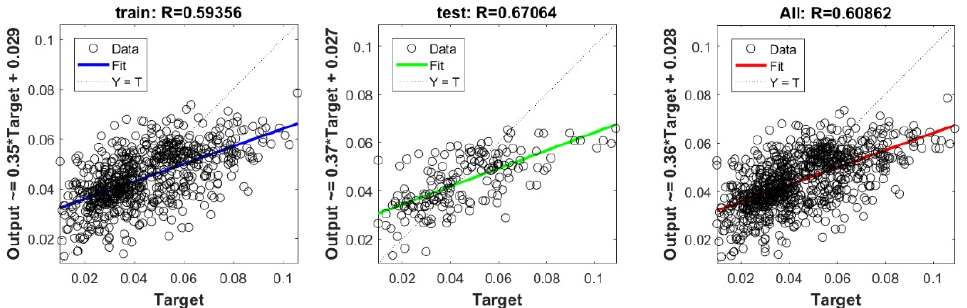
Figure A7. Scatter plots between target and output value by the FS-PLS model.